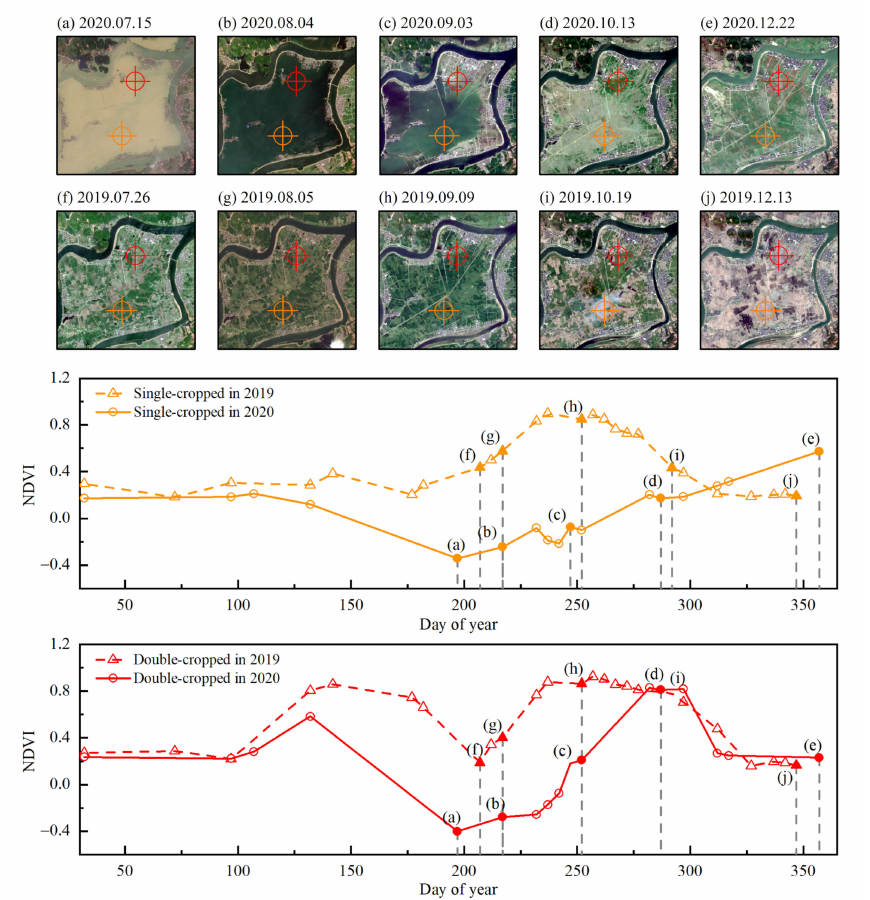
Figure 5. The RGB composite of Sentinel-2 imagery in close dates of 2019 and 2020 shows gradual agricultural recovery after the flooding in 2020 in the Changzhou Township, Poyang County. The red and orange points indicate diverse recovery conditions due to different positions, cropping intensity, and flooding duration. The solid and dashed lines represent temporal trajectories of NDVI based on the two selected pixels in 2020 and 2019 separately. NDVI was derived from time series of Sentinel-2 imagery. ( a – e ) Sentinel-2 images acquired after flooding in 2020, ( f – j ) Sentinel-2 images in 2019 acquired with close dates in correspondance to the year of